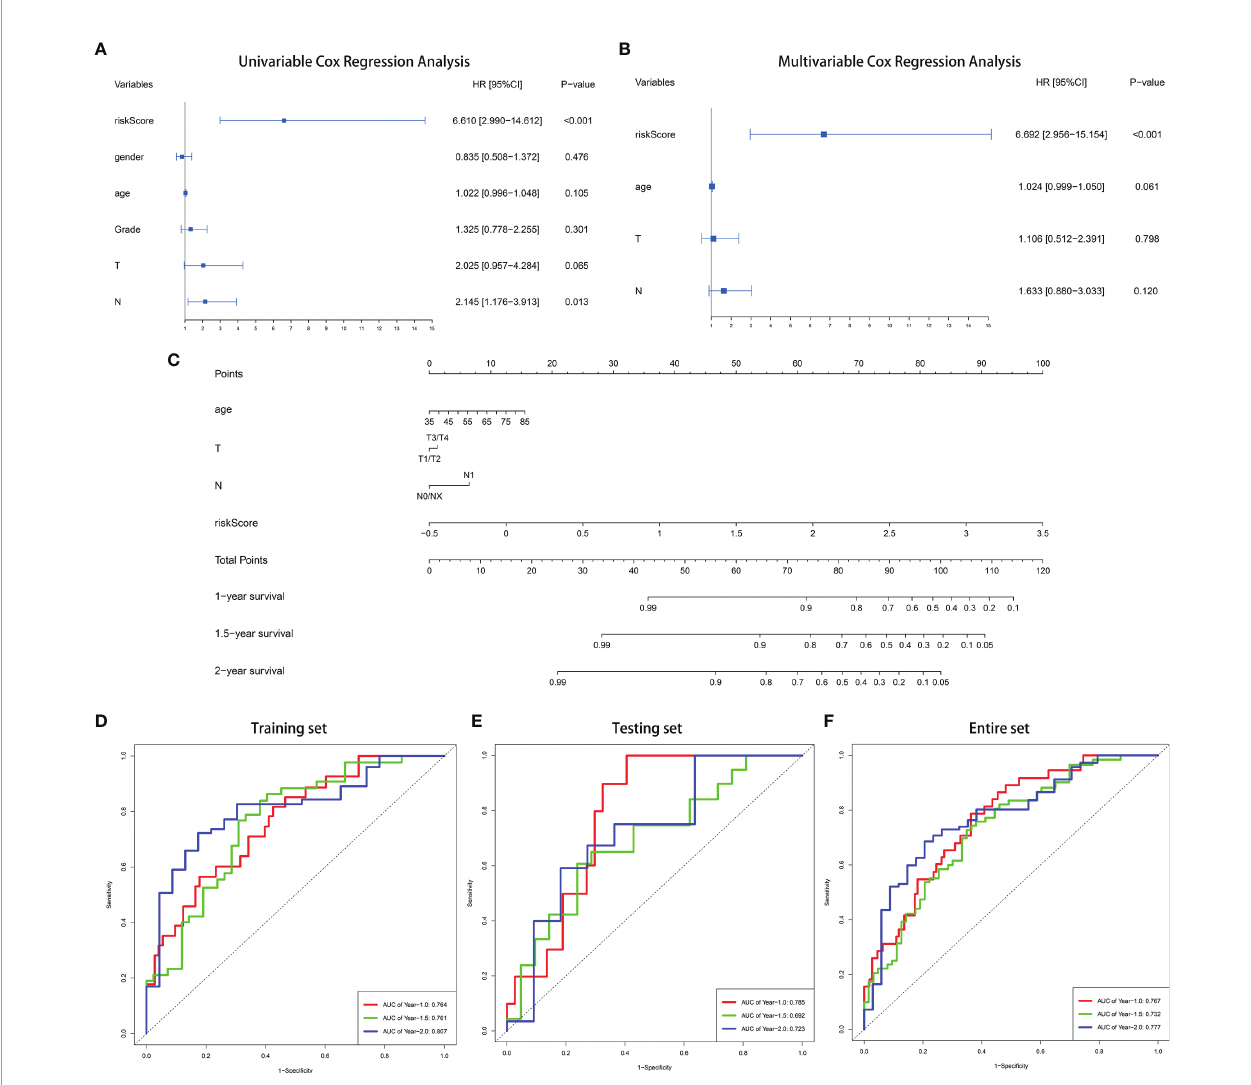
FIGURE 3 | Construction of a nomogram for predicting 1-, 1.5-, and 2-year survival rate of PC. (A) Forrest plot of univariate Cox regression analysis in training set. (B) Forrest plot of multivariate Cox regression analysis in in training set. (C) Nomogram integrating nine IRGs-based risk score, age, T stage and N stage. (D – F) Time-dependent ROC analysis of the nomogram in training set, testing set and entire TCGA